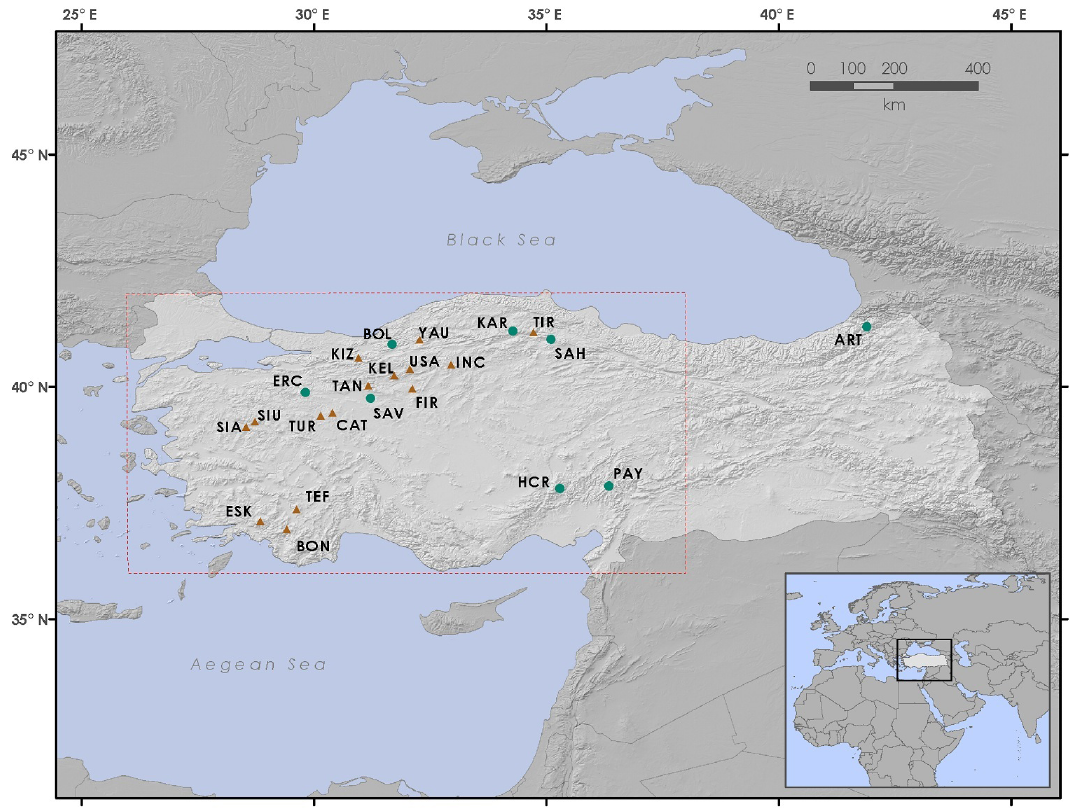
Figure 1. Tree-ring chronology sites in Turkey used to reconstruct temperature. Circles represent the new sampling efforts from this study and the triangles represent previously published chronologies (YAU, SIA and SIU in Mutlu et al., 2011. TIR in Akkemik et al., 2008. TAN in Köse et al., 2013. KIZ, ESK, TEF, BON, KEL, USA, FIR and TUR in Köse et al., 2011. CAT and INC in Köse et al., 2005). The box (dashed line) represents the area for which the temperature reconstruction was